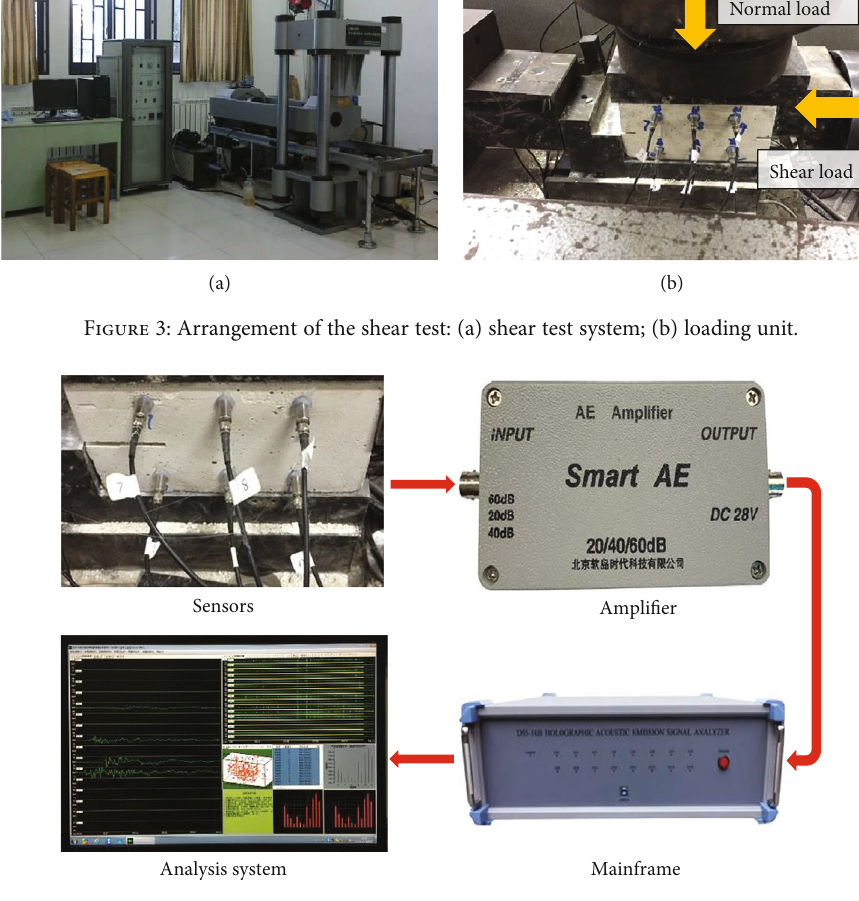
Figure 4: DS5-16B AE monitoring